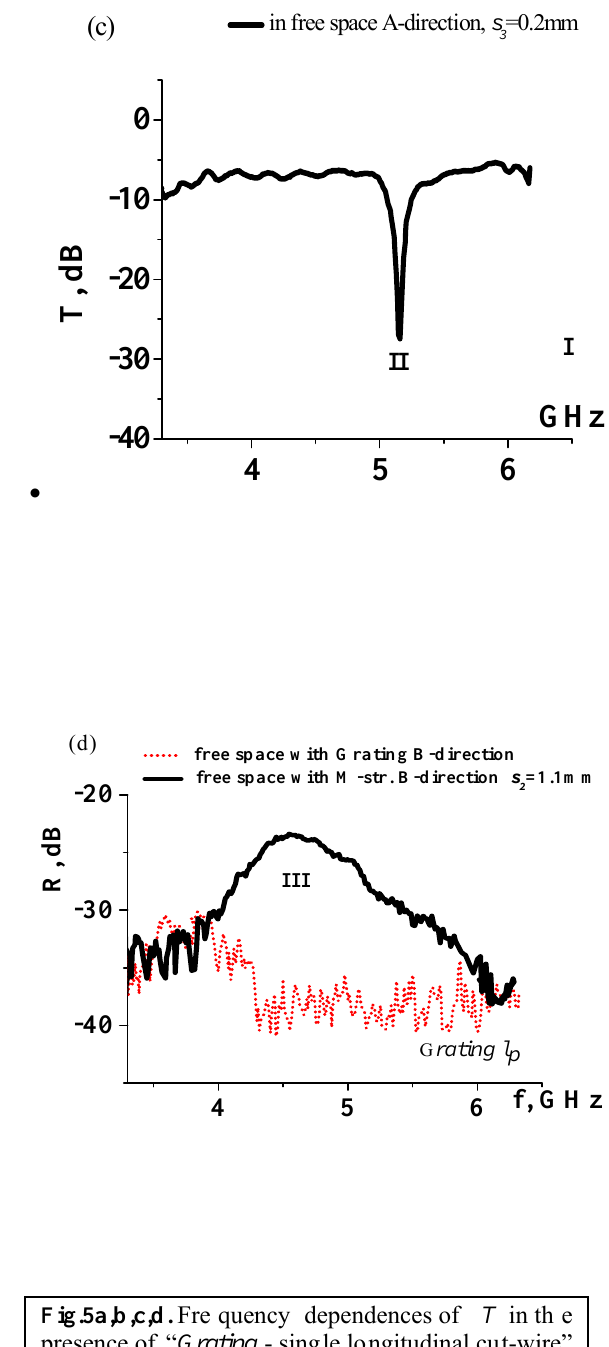
Fig.5a,b,c,d. Fre quency dependences of T in th e presence of “ Grating - single longitudinal cut-wire” metastructure ( l p =16mm, l m =23mm, s 1 =2.7, s 2 =1.1, s 3 =0.2mm) in (a, b) WG (dashed) a nd c utoff WG (solid) and (c,d) free space (A- and